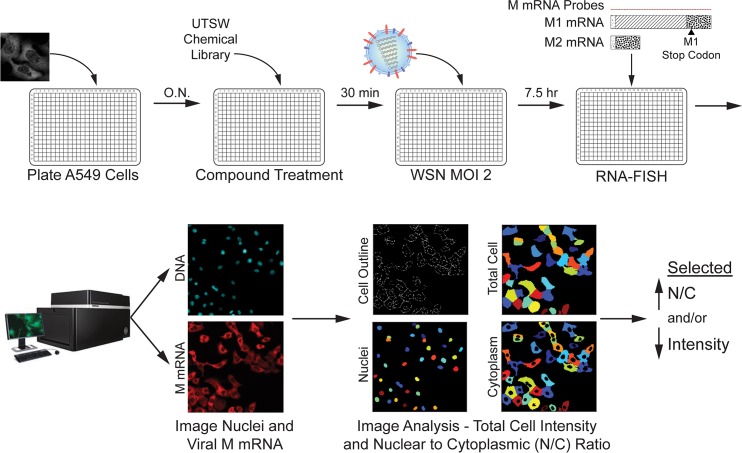
Schematic representation of a high-throughput screen to identify chemical inhibitors of viral M mRNA processing and nuclear export.Screen was performed using a chemical library of 232,500 compounds in A549 cells. Cells were incubated with compounds for 30 min and, for robust imaging analysis, ~ 100% of the cells were infected with influenza virus (WSN), at MOI 2 for 7.5h. Viral M mRNA was detected by smRNA-FISH and images were systematically taken in a high throughput microscope (IN Cell Analyzer 6000). Samples on 384-well black clear-bottom plates were imaged at 20X magnification using the Hoechst and dsRed filters. 4 fields of view per well were collected for each channel. The distribution of fluorescent signal between the nucleus (N) and the cytoplasm (N/C ratio) as well as total cell signal intensity were quantified using GE IN Cell Analyzer Workstation (version 3.7.3) and Pipeline Pilot (version 9.5; Biovia). Data was imported into the GeneData’s Screener™ software analysis suite for quality control to ensure that data quality is high for all plates in each experimental run (Z’ > 0.4).